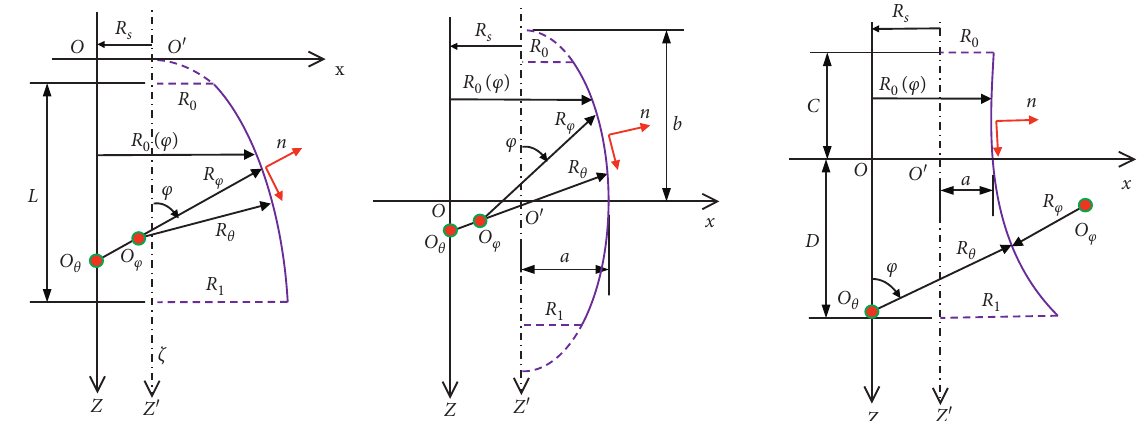
Figure 2: Generatrix diagram of three Sandwich FGP doubly curved